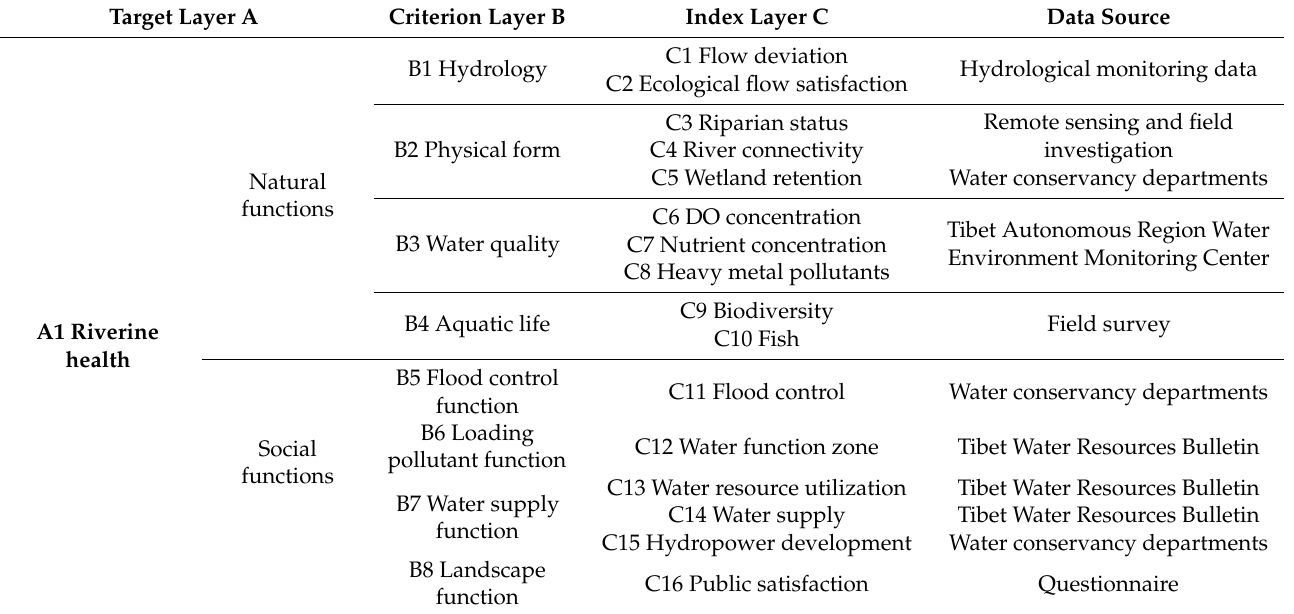
Table 1. The list of indicators for riverine health